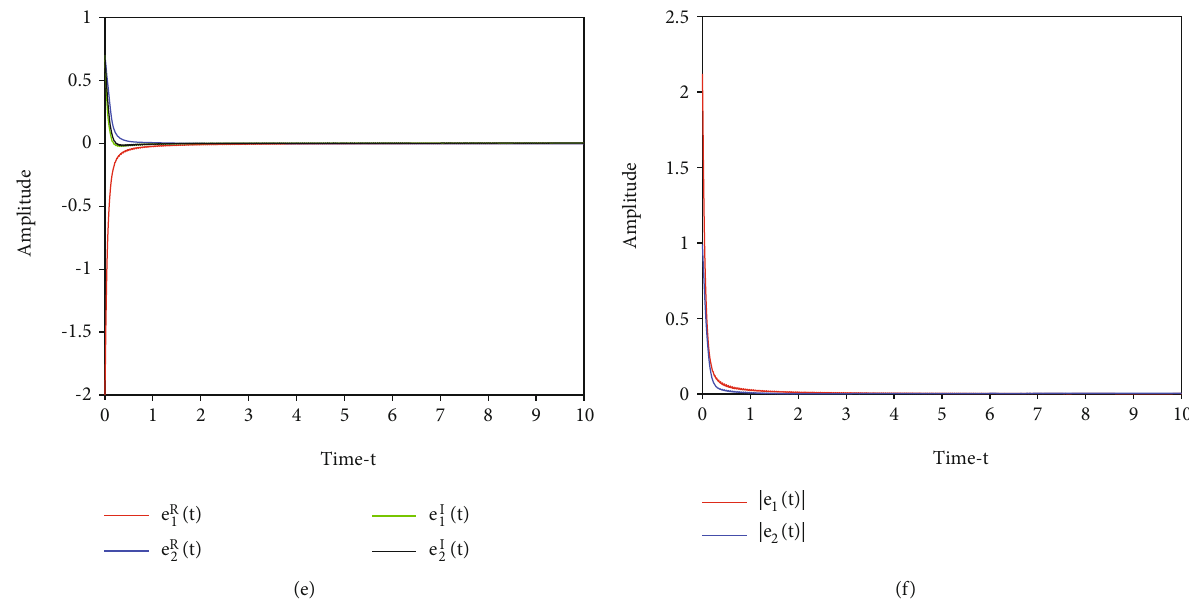
Figure 2: (a, b) The real parts of synchronization state trajectories with controller (24). (c, d) The imaginary parts of synchronization state trajectories with controller (24). (e) The error trajectories with controller (24). (f) The error modulus trajectories with controller